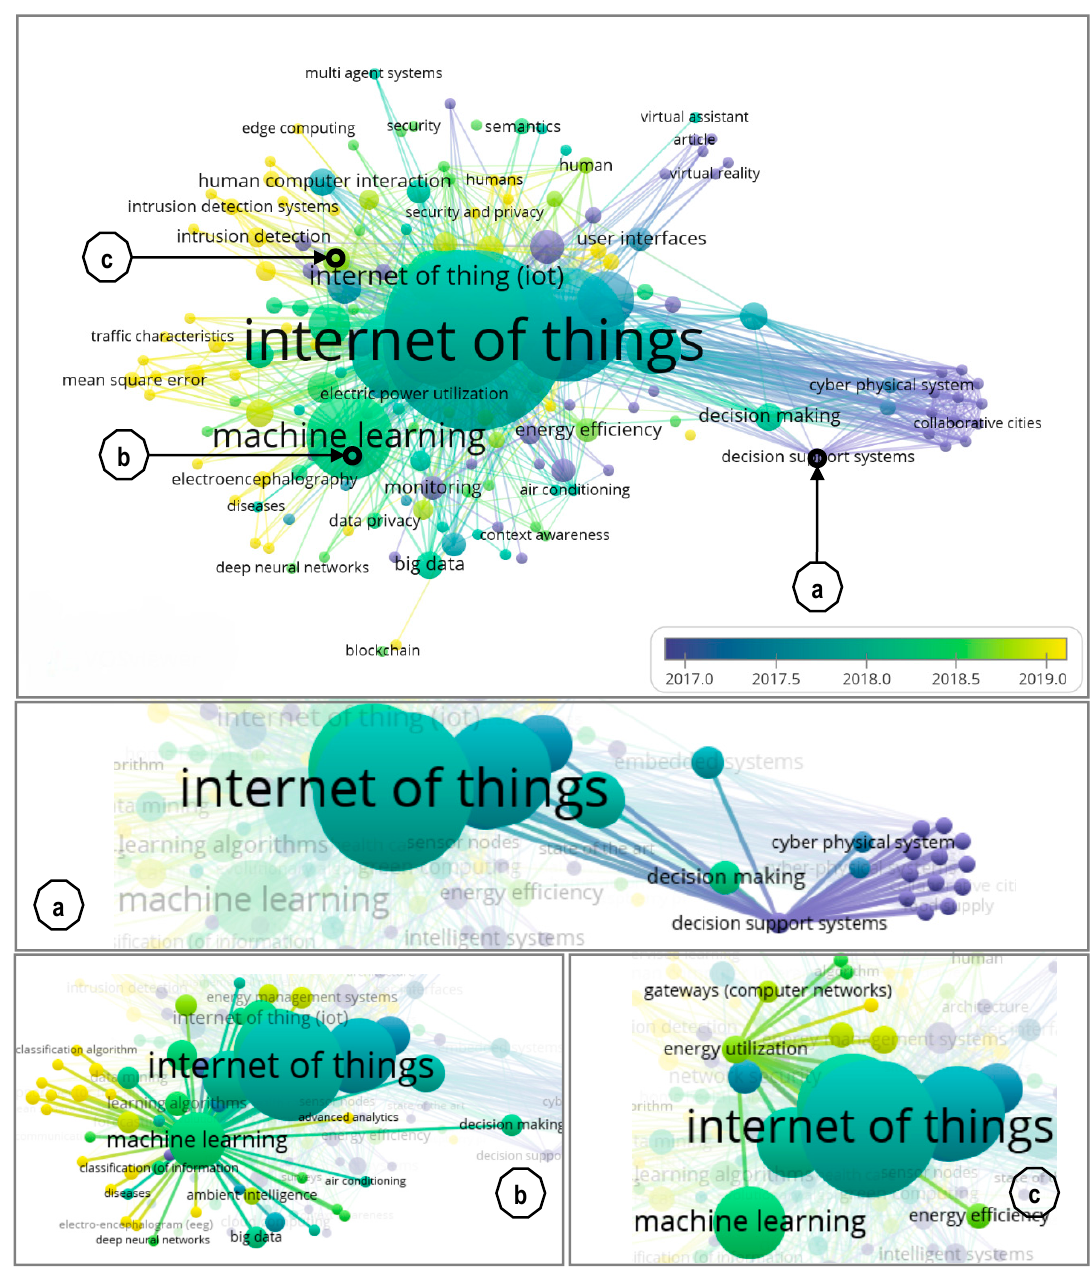
Figure 5. Co-occurrence analytical map of selected keywords extracted from the bibliographic dataset: ( a ) the map of decision support systems; ( b ) the map of machine learning; ( c ) the map of energy